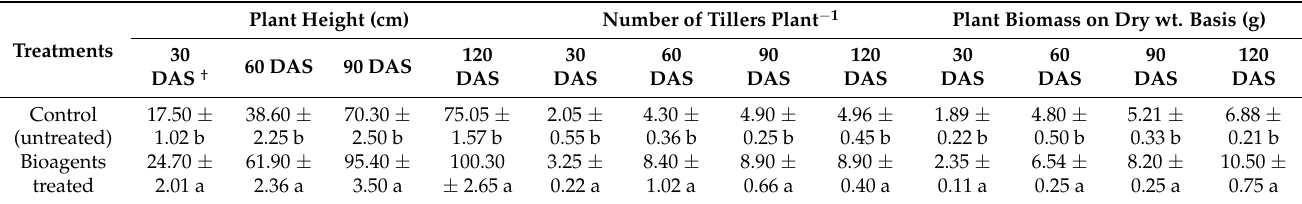
Table 4. Effect of bioagents on different growth parameters of wheat plants grown under salt stress conditions. Plant Height (cm) Number of Tillers Plant − 1 Plant Biomass on Dry wt. Basis (g) Treatments Control